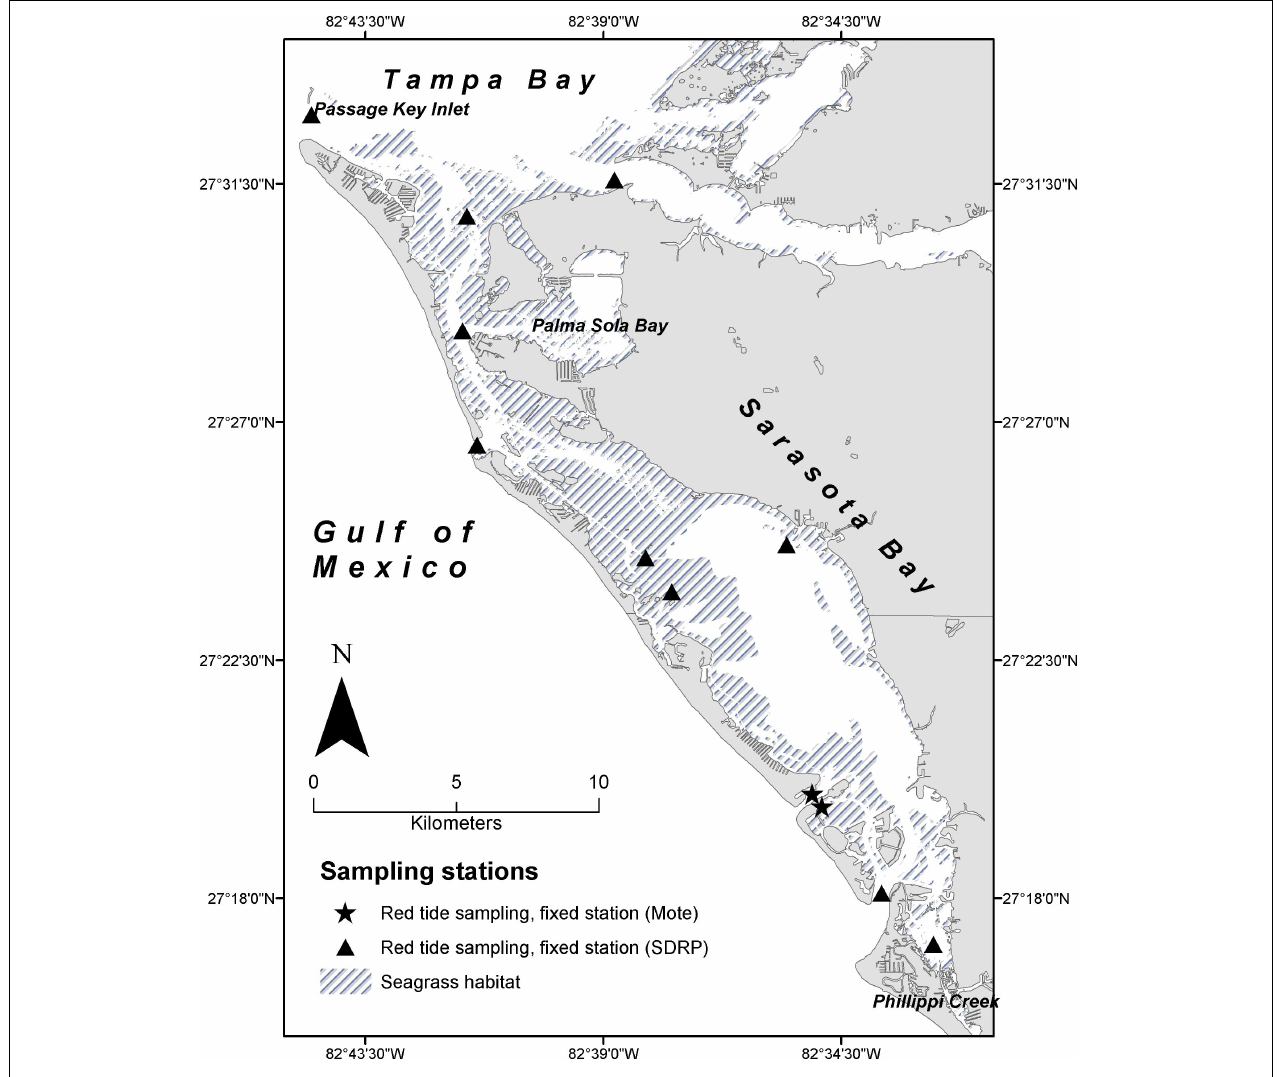
FIGURE 1 | Study area showing locations seagrass habitat and of daily and monthly Karenia brevis fixed monitoring stations sampled by Mote Marine Laboratory (New Pass and City Island Grass Flats) and the Chicago Zoological Society’s Sarasota Dolphin Research Program (SDRP),